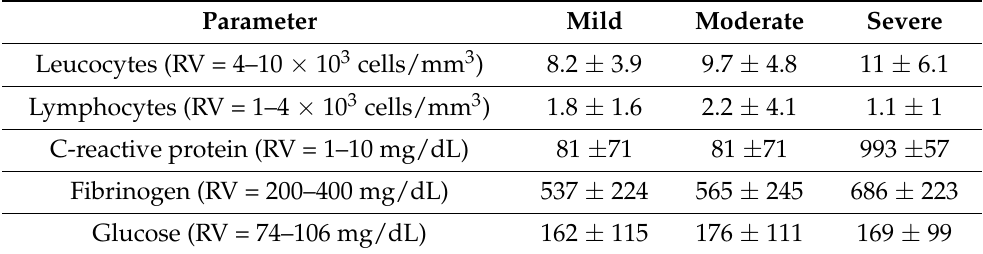
Table 3. Clinical parameters measured at the time of institutional admission.